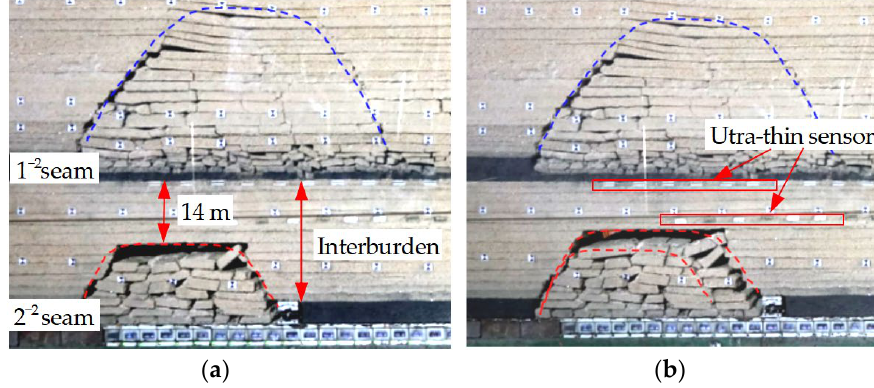
Figure 7. Law of weighting during the interburden unbroken: ( a ) FW. ( b ) FPW1.